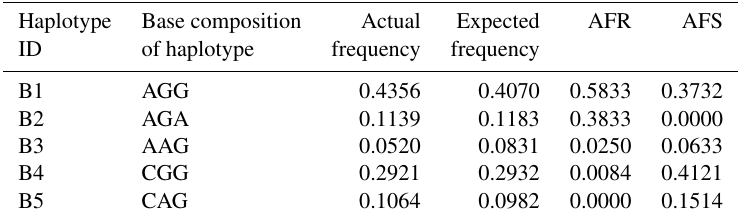
Table 3. Frequencies of CSN1S2 haplotypes in two types of buffalo.